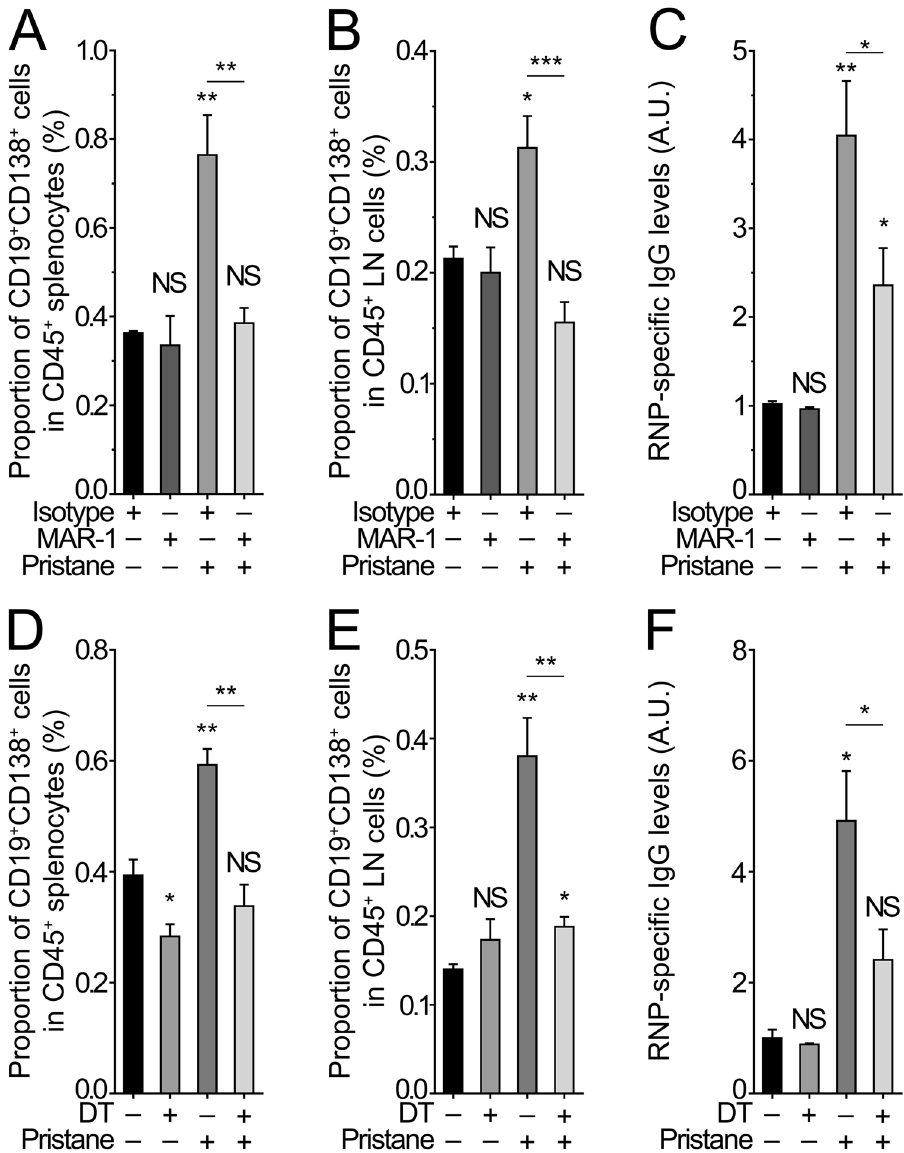
Figure 3. Basophil depletion dampens proportions of short-lived CD19 + CD138 + plasma cells in SLOs and serum autoantibody titers during pristane-induced lupus-like disease. ( A , B , D , E ) Proportion of CD19 + CD138 + cells among living CD45 + cells (defined as CD45 + TCR β − CD19 + CD138 + ) in SLOs (spleen ( A , D ) and lymph nodes ( B , E )) from the same mice as in Fig. 2 and as determined by flow cytometry. ( C , F ) Levels of anti-RNP specific IgG in serum from the same mice as in Fig. 2. Optical density values at 450 nm were normalized to mean value of the control group for each set of experiments (PBS-injected basophil-sufficient mice). Data are presented as mean + s.e.m. Statistical analyses were by unpaired Student t tests. NS, not significant; * p < 0.05, ** p < 0.01, *** p < 0.001. A.U.: arbitrary